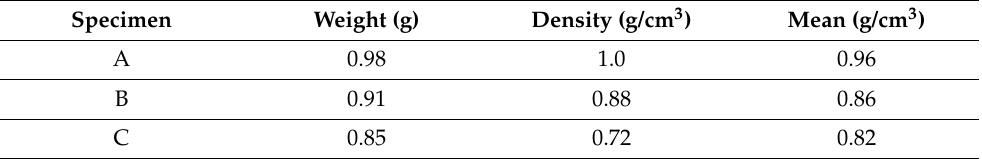
Table 5. Measured density of specimens A, B, and C at difference resin ratios. Specimen Weight (g)